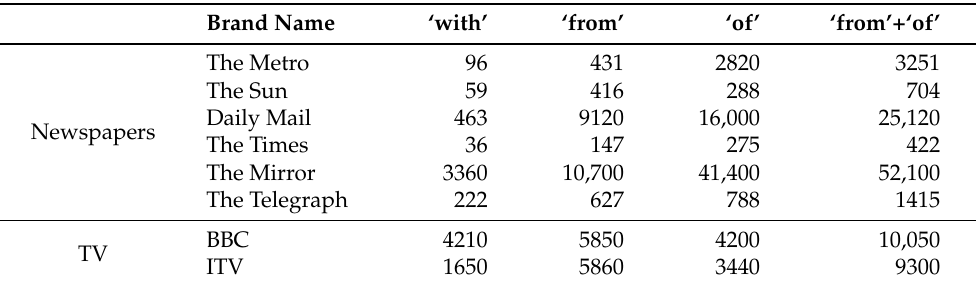
Table 1. Summary of UK data.